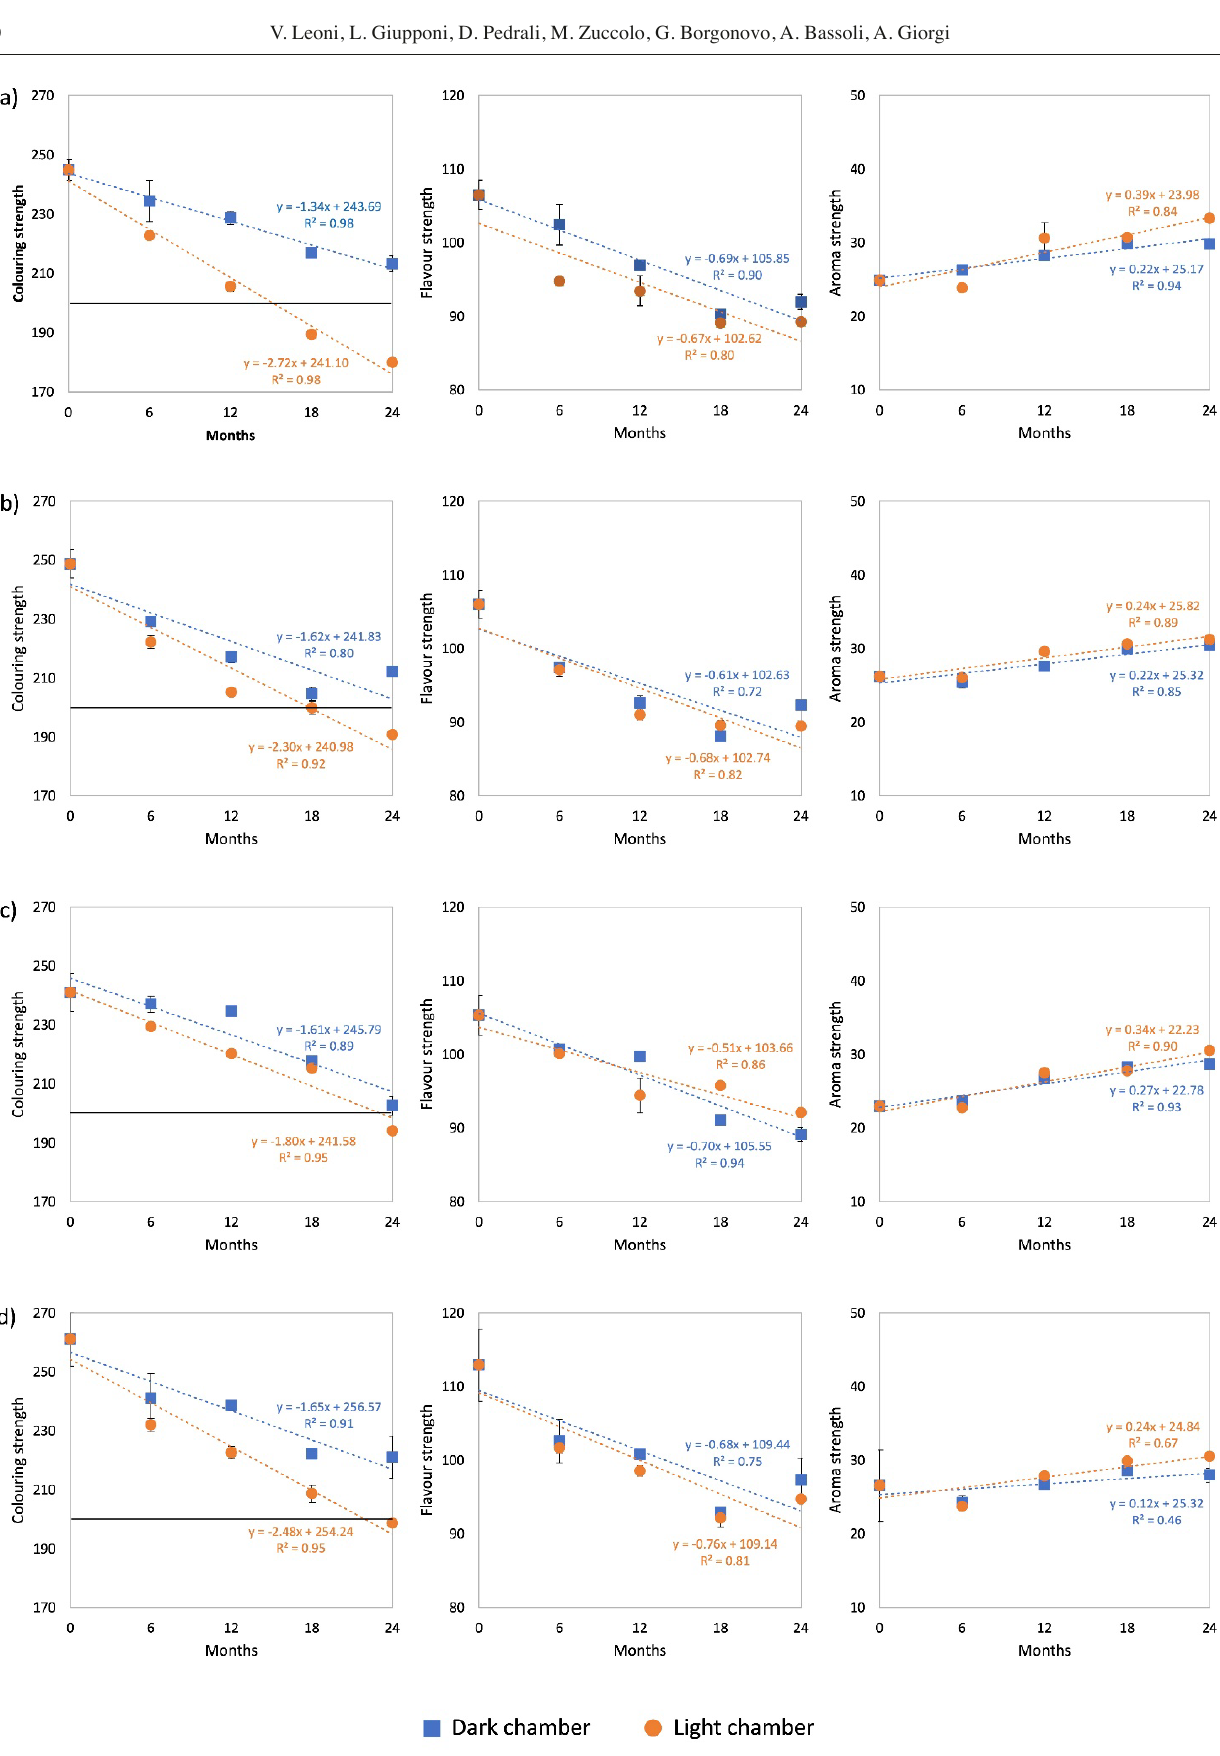
Fig. 6: Colouring, flavour, and aroma strength degradation trendline for samples 31 (a), 32 (b), 33 (c) and 34 (d) preserved in the dark chamber and in the light chamber. The black line indicates the limit of the first quality category for colouring